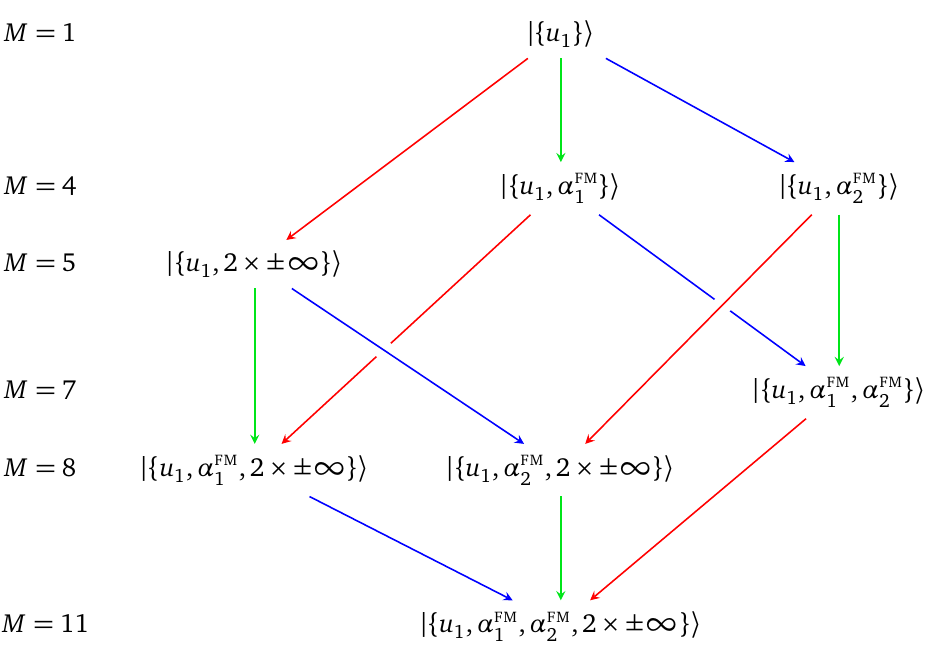
}〉 with finite u for N = 12, ∆ = 1 / 2, φ = 1 1